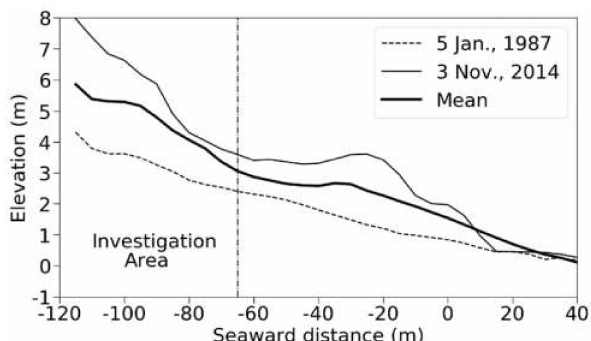
Figure 3. Mean beach profile and the profiles at the beginning and end of the investigation period from x = − 115 to 40 m along the survey line indicated in Figure 2.